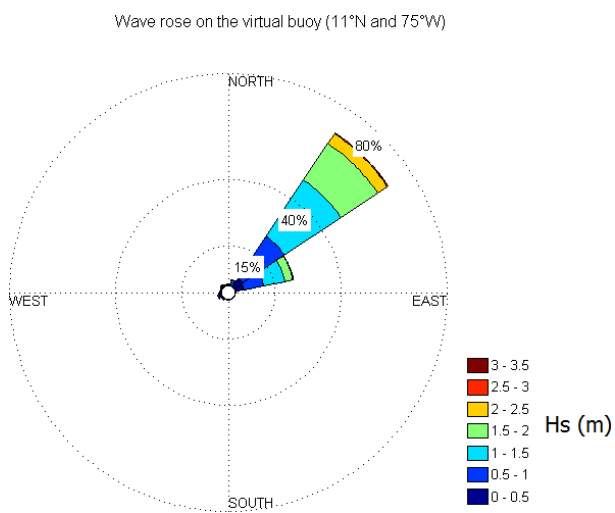
Fig. 10. Wave rose of the virtual